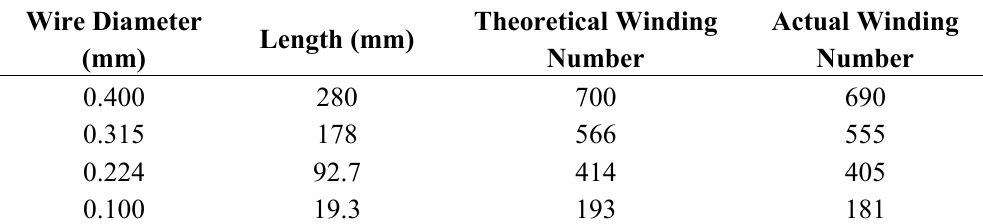
Table 1. Characteristic of the different coils.